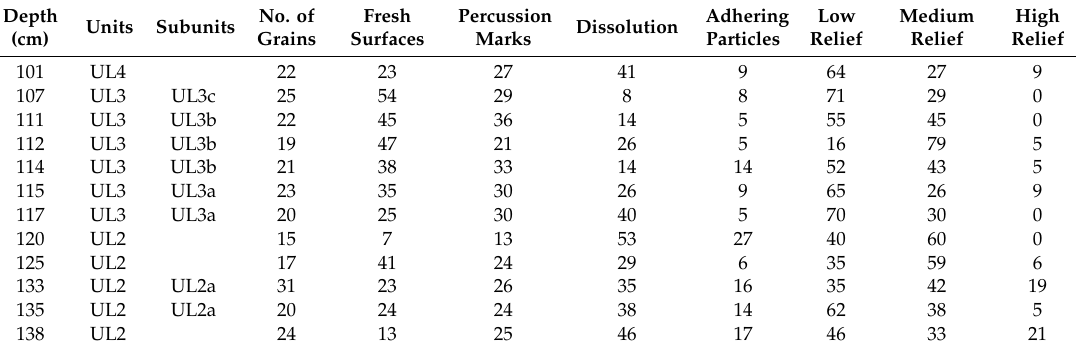
Table 2. Results of the microtextural classification based on the most recent microtexture identified on the surface of each grain. The values represent the frequency of each microtextural attribute in each sample. Depth Units Subunits (cm)